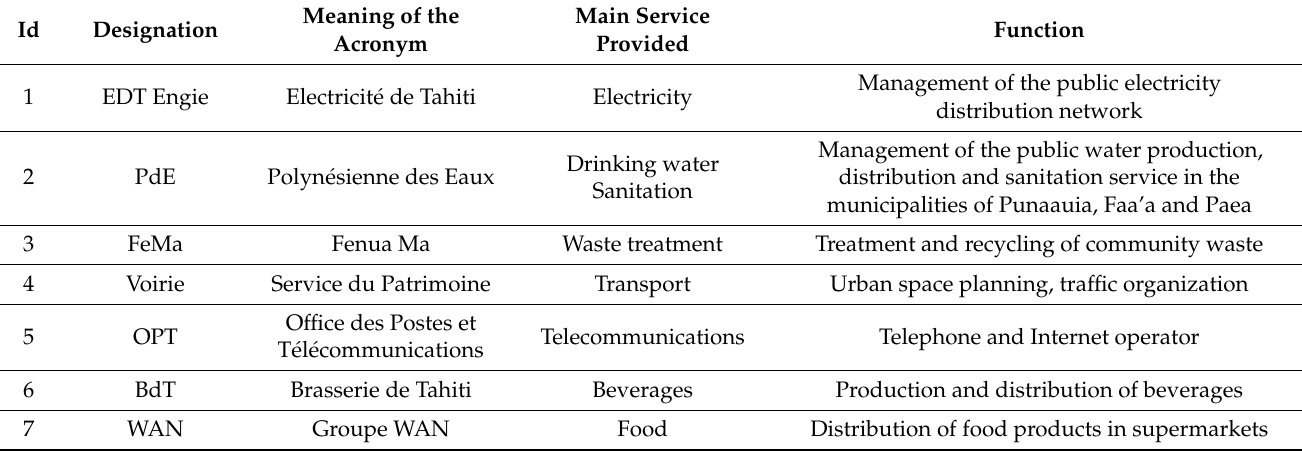
Table 2. Example of urban services encountered in Punaauia, status and functions adapted from (Toubin, 2014)